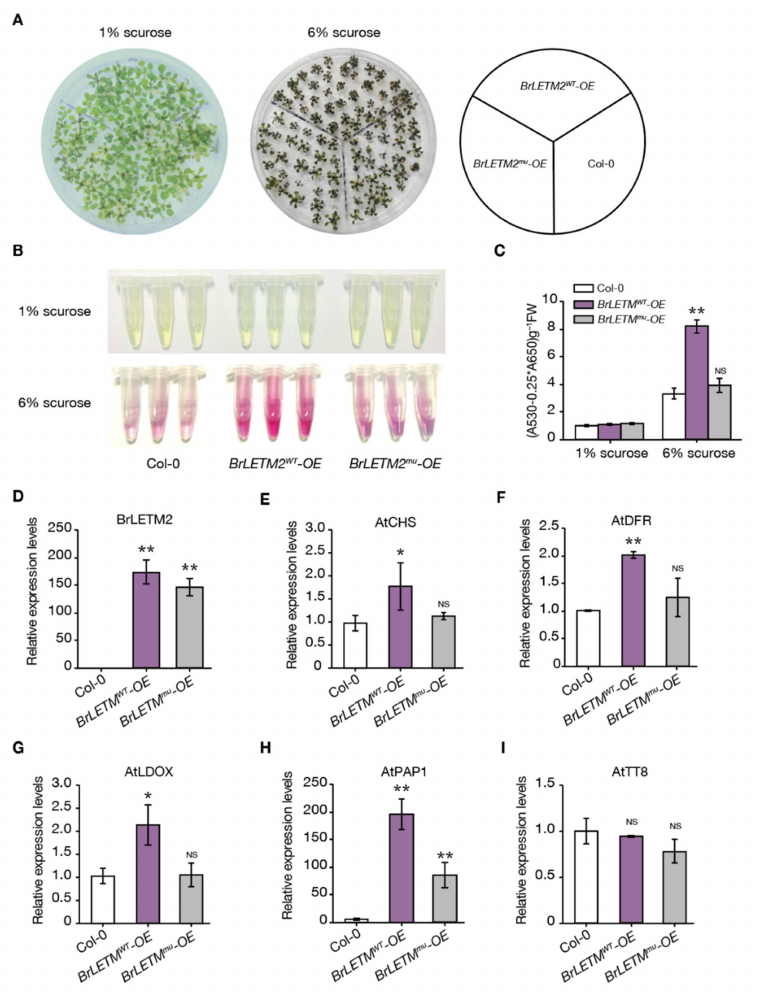
Figure 4. BrLETM2 promotes anthocyanin biosynthesis in response to high sucrose in 14-day-old seedlings of Arabidopsis . ( A ) Seedlings of Col-0, BrLETM2 WT -OE and BrLETM2 mu -OE were grown on plates with normal sucrose (1%) and high sucrose (6%). ( B , C ) Anthocyanin levels of seedlings in ( A ). ( D – I ) Expression levels of BrLETM2 , AtCHS , AtDFR , AtLDOX , AtPAP1 , and AtTT8 in seedlings in ( A ) were quantified by qRT-PCR. Expression level of Col-0 was set at 1 and AtACTIN8 was used for normalization. Values are means ± SD ( n = 3); asterisks indicate a significant difference between Col-0 and overexpression lines (* p < 0.05, ** p < 0.01, Student’s t